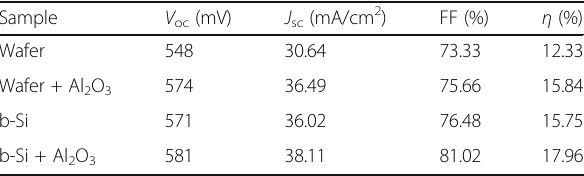
Table 1 Photovoltaic parameters for the solar cells of “ wafer, ” “